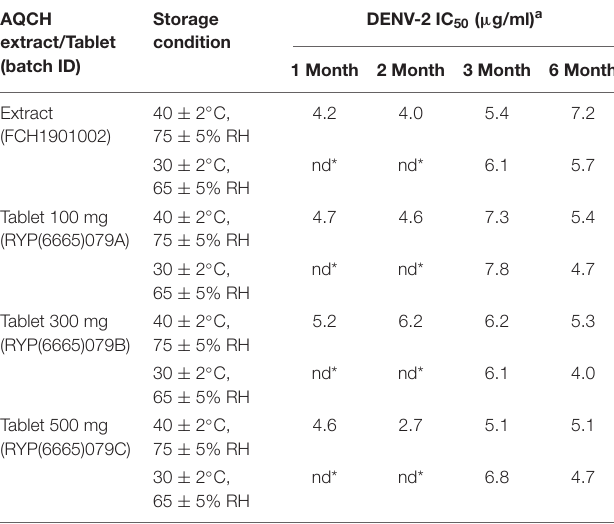
TABLE 1 | Anti-DENV-2 activity of AQCH and AQCH tablets under the stated conditions of storage. AQCH